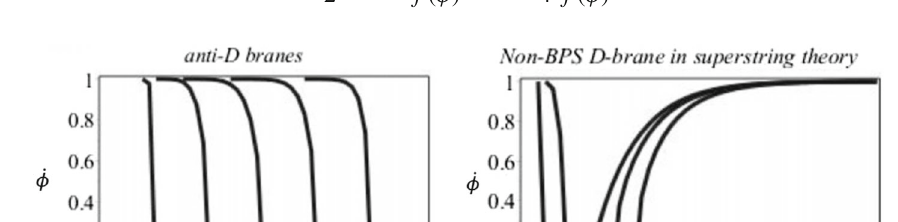
Fig. 4 Phase space diagram for V (φ) = V . φ − 2 with V . = 2 coupling constant f (φ) = 1 (II) f ( φ ) = φ 2 : In this case we choose f (φ) = φ 2 for cou- pling of field with torsion scalar. For the different potentials used previously, we have the phase space diagrams depicted in Fig. 5. As illustrated above, for f (φ) = φ 2 the dynamical behavior of the tachyonic field does not change for the used potentials. The only difference is that except anti-D brane, we can see in the other potentials that for the boundary condition φ < 1, decreasing of the tachyonic field, causes ˙ φ tending to one and tachyonic terms will be decoupled from teleparallel gravity.